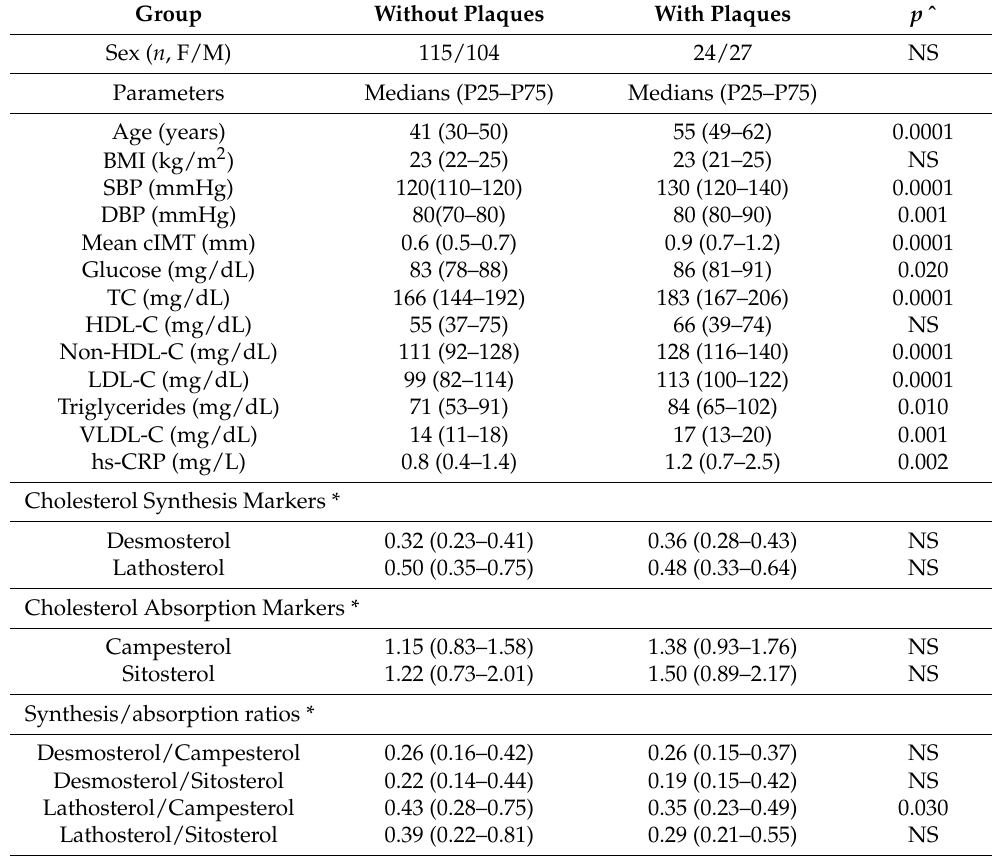
Table 4. Comparative analyses of clinical, anthropometrical, and biochemical characteristics of subjects according to the presence or absence of atherosclerotic plaques.